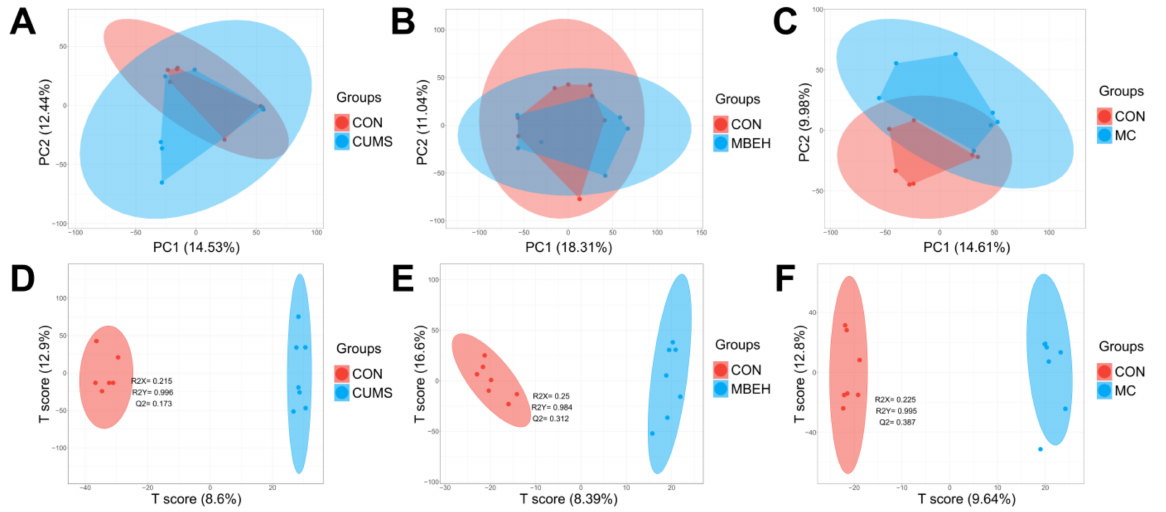
Figure 4. The PCA and sPLSDA score plots of each model. ( A – C ) The PCA score plot of CUMS, MBEH and MC mice. ( D – F ) The sPLSDA score plot of CUMS, MBEH and MC mice. Red represents the control group; blue represents the model group.